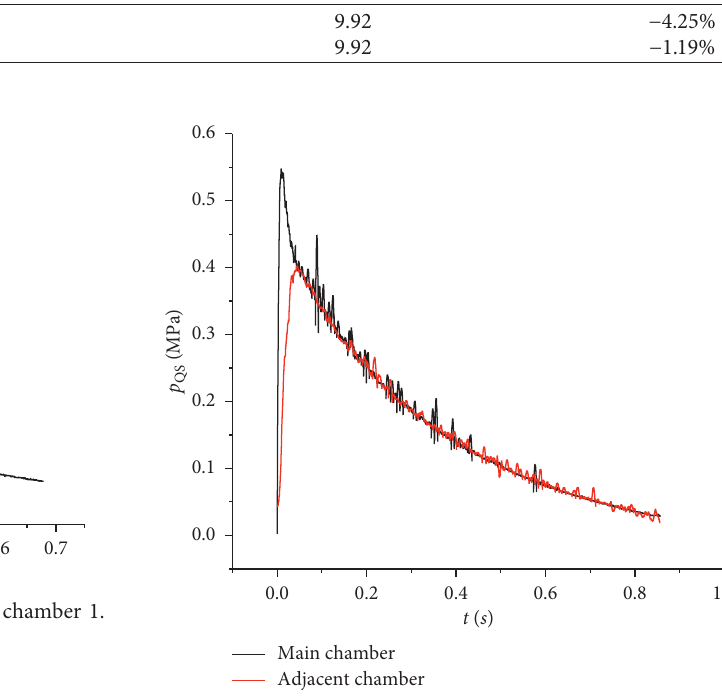
Figure 6: Quasistatic pressure p-t curves of the main chamber and adjacent chamber in simulated chamber